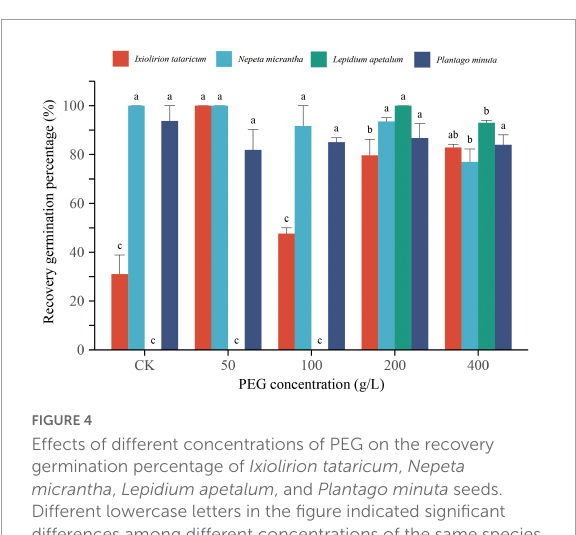
FIGURE4 Effects of different concentrations of PEG on the recovery germination percentage of Ixiolirion tataricum , Nepeta micrantha , Lepidium apetalum , and Plantago minuta seeds. Different lowercase letters in the figure indicated significant differences among different concentrations of the same species ( P <